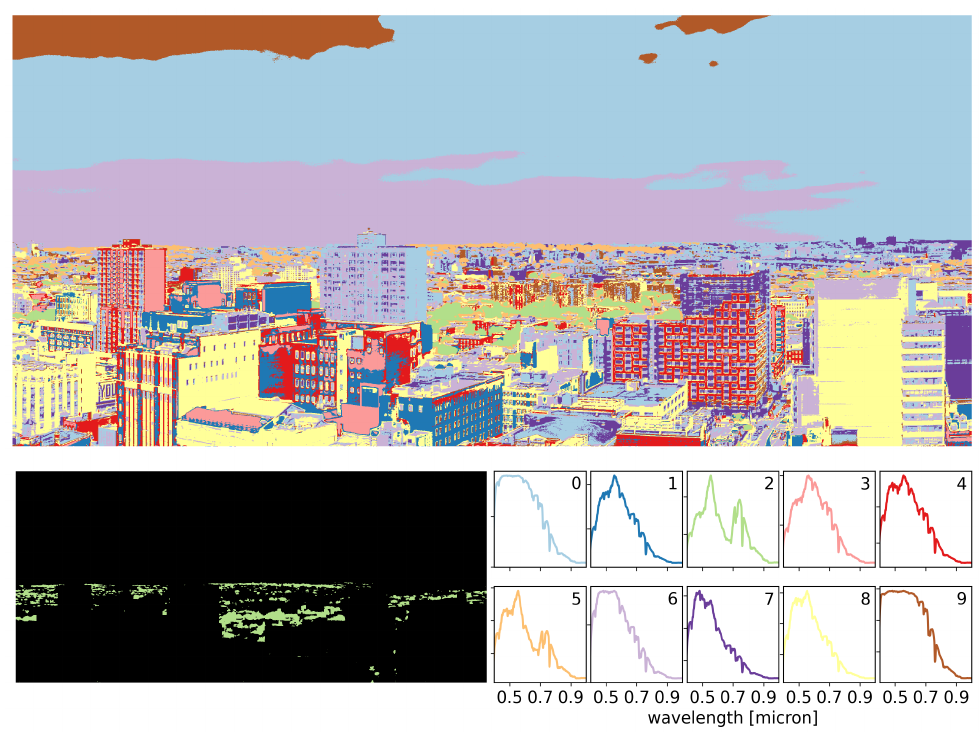
Figure 2. ( Top ): The cluster labels for a k = 10 k -means clustering of pixel spectra from the scene in Figure 1. An image of only pixels labeled as cluster 2 or cluster 5 is shown in the ( bottom left ). These cluster centers have spectra ( bottom right ) with enhanced green and near-infrared wavelengths, characteristic of chlorophyll reflectance, and so pixels labeled as belonging to those clusters are interpreted as